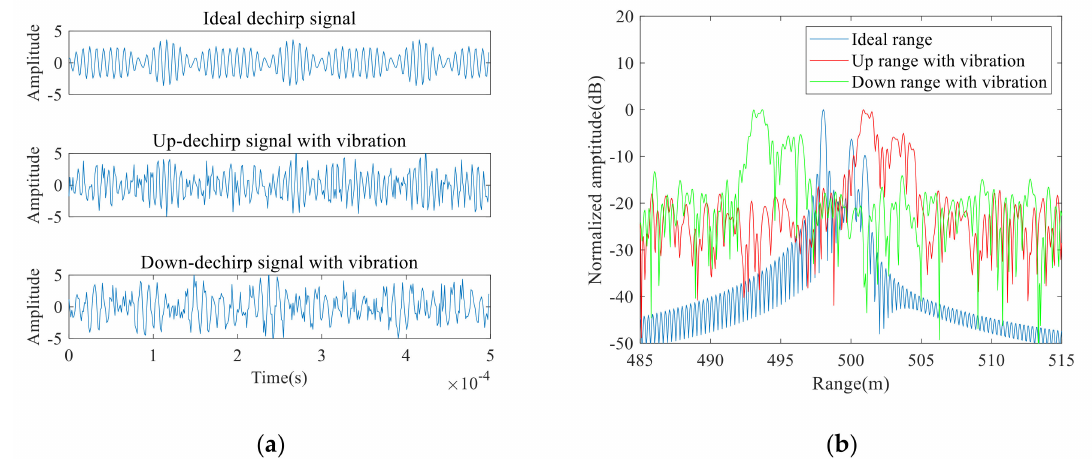
Figure 11. ( a ) Dechirp signals; ( b ) One-dimensional range distributions.